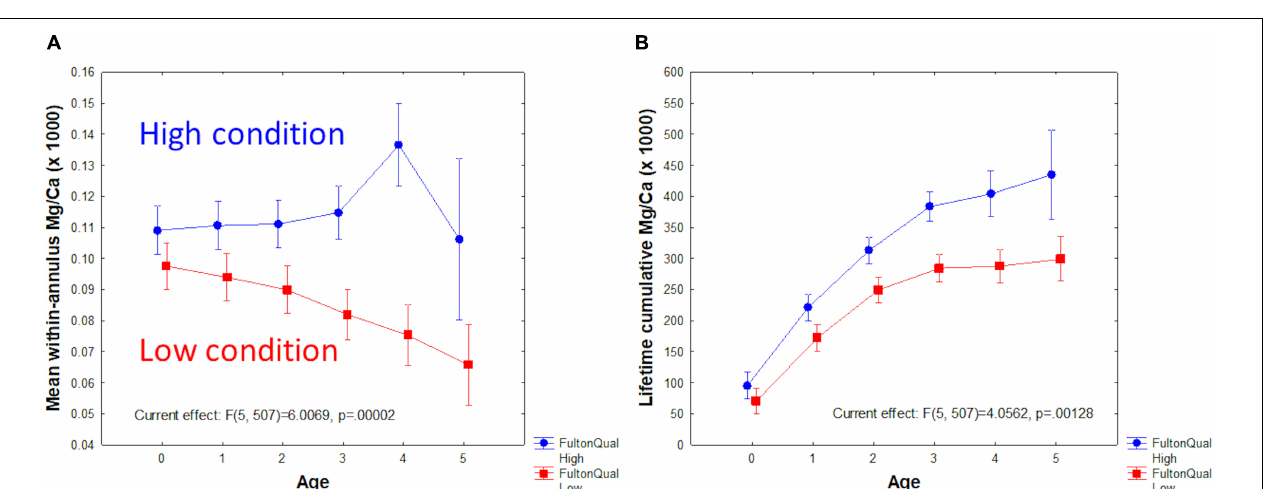
FIGURE 5 | (A) Within-year otolith Mn/Mg exceeding median threshold, a proxy for within-year duration of hypoxia exposure in Baltic cod otoliths, 1986–2016. (B) Concordance of Baltic Sea hypoxic water volume over the same time period, defined as water holding < 2 mL/L dissolved oxygen (data courtesy O. Savchuk, Baltic Sea Centre, Stockholm University), and median otolith proxy values (from A ) lagged 1 year back; note different axis scales; observations of N ≤ 2 were deleted. (C) Median lagged otolith proxy values (from B ), plotted vs. Baltic Sea hypoxia volume.